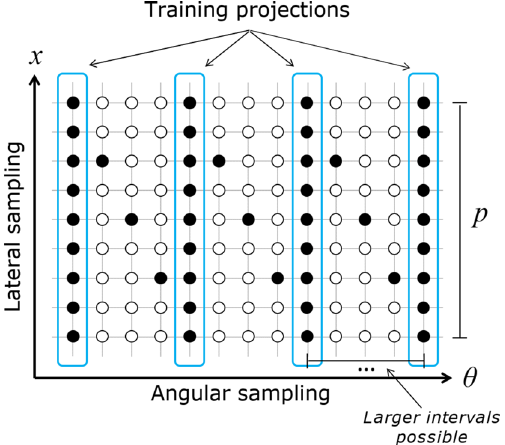
Figure 2. Cycloidal sinogram sampling pattern with training projections interleaved. The grid is shown for a subset of angles and one mask period ( p ). The filled circles represent the sampled data points, while the empty circles represent the ones not sampled. Note that the angular interval between training projections is typically substantially larger than indicated here for illustrative purposes. This figure is adapted from 35 .